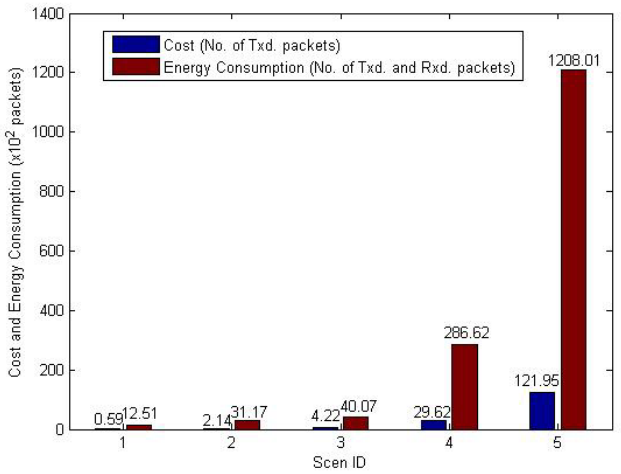
Figure 17. Cost and energy consumption of level building